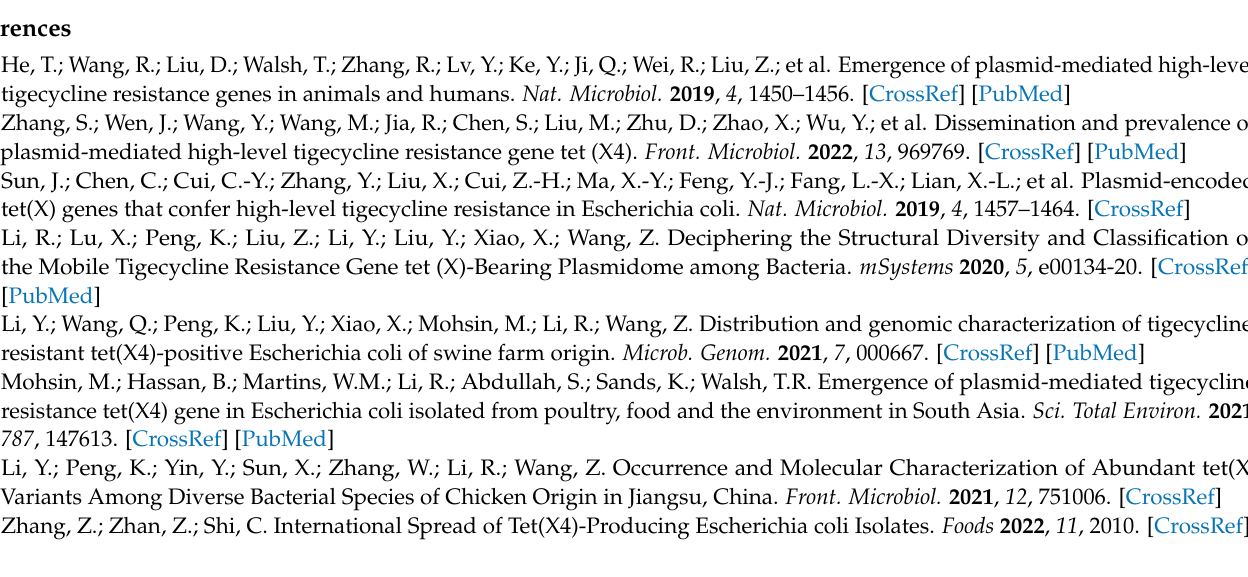
Table S3: Basic information of tet (X4)-bearing plasmids in this